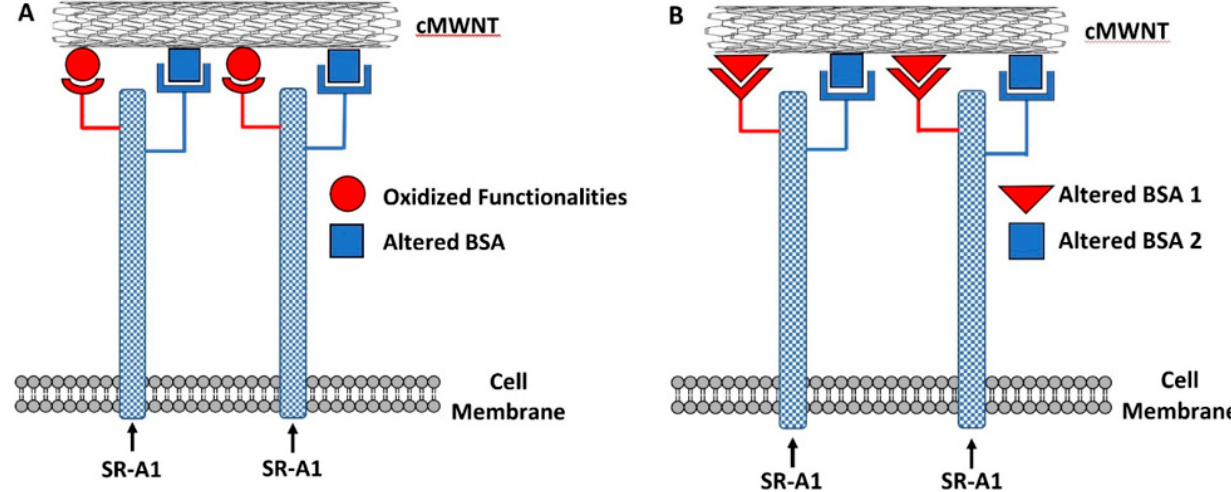
Figure 10. Models for the binding of cMWNTs to SR-A1. ( A ) Model where one site on SR-A1 interacts with altered binding sites on a BSA conformer and another site interacts with oxidized functionalities on cMWNTs. ( B ) Model where one site on SR-A1 interacts with altered binding sites on BSA Conformer 1 and another site interacts with altered binding sites on BSA Conformer 2.